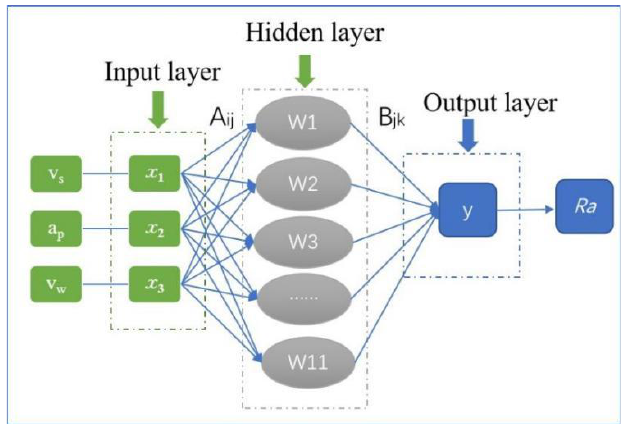
Figure 9. BP neural network structure.